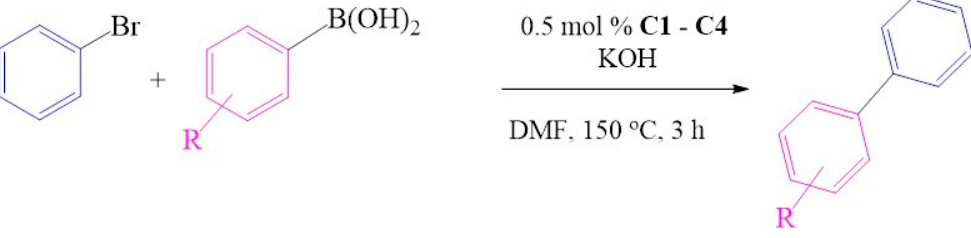
Figure 22. Suzuki ‐ Miyaura coupling of bromobenzene with substituted phenylboronic acid under optimum conditions. Table 10. Results obtained from Suzuki ‐ Miyaura coupling of bromobenzene with substituted phenylboronic acid under optimum conditions. Cat.